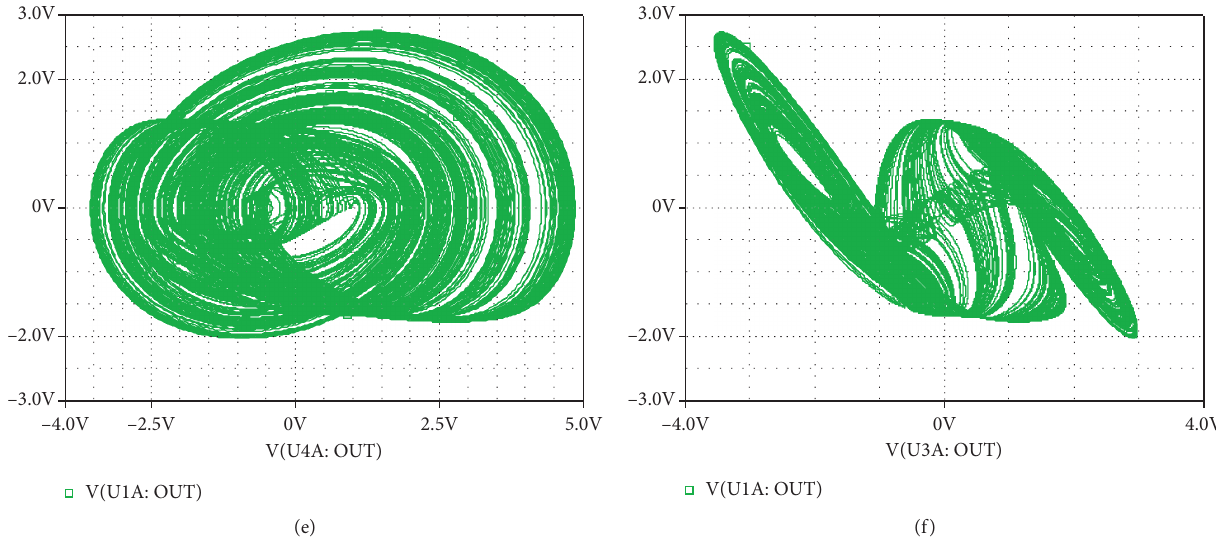
Figure 18: Two-dimensional views (left panel) of the asymmetric double-scroll chaotic attractors computed for a � 5 . 0 and k � 0 . 25 and the corresponding PSpice simulation results (right panel) obtained for R c � 12k Ω , R k � 576k Ω , and R